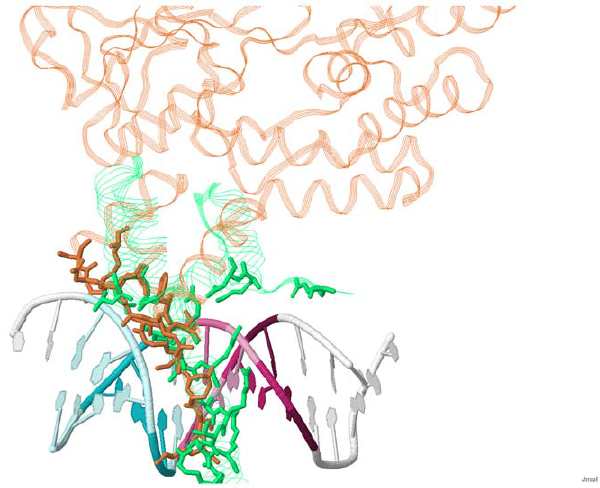
templates still has the potential to produce satisfied results. This figure contains two proteins that share similar DNA-binding interface but have low global structure similarity (TM-score=0.38). The Y -score of the predicted PWM to the annotated PWM using the orange protein (1MH3:A, MATA1_YEAST) as the query and the green protein (1SKN:P, SKN1_CAEEL) as the template is 0.18. Contact residues on both protein structures are plotted in sticks presentation.